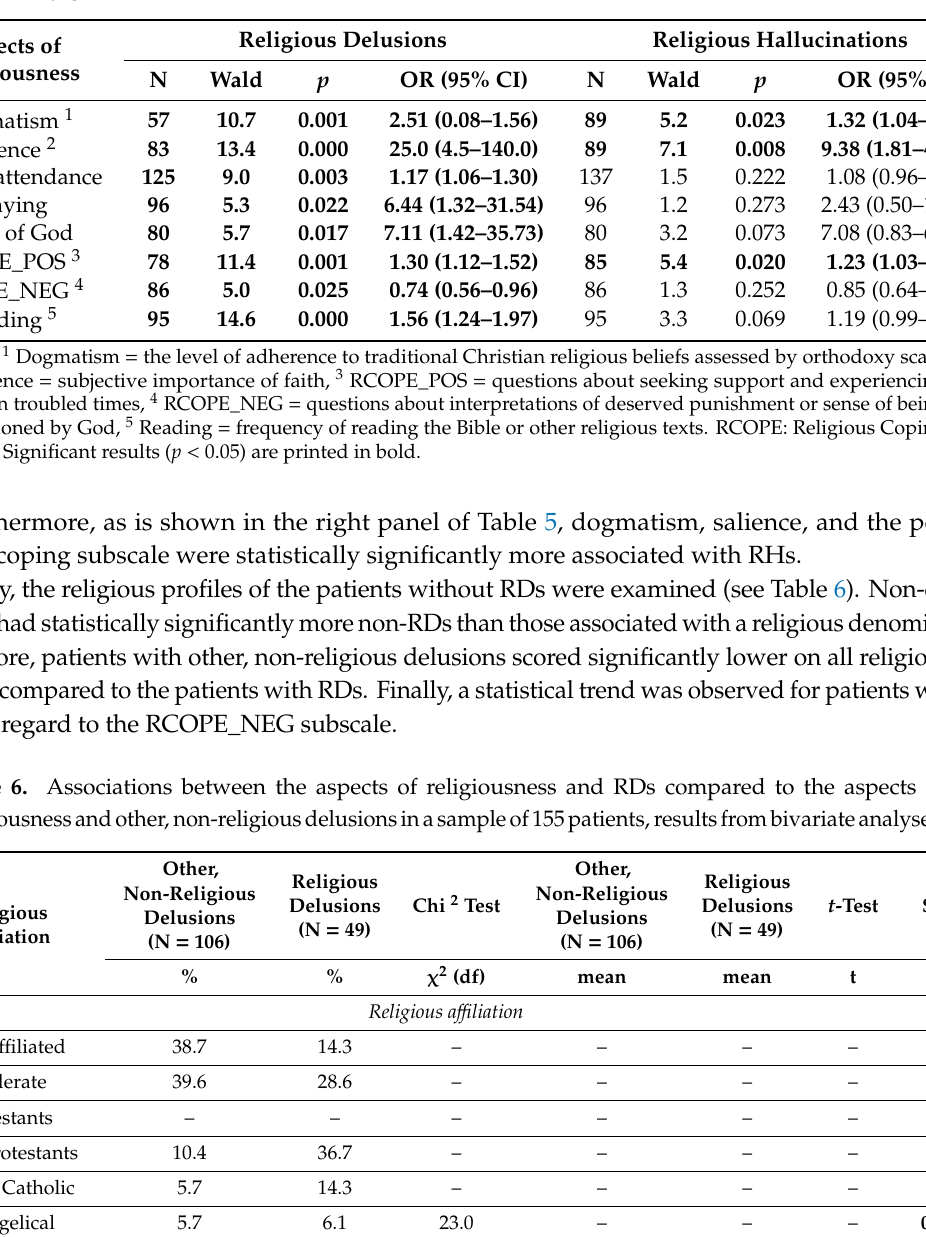
Table 5. Associations between other aspects of religiousness and RDs and RHs in a sample of 155 patients; results of separate logistic regression analyses for other aspects of religiousness adjusted for e ff ect by gender.